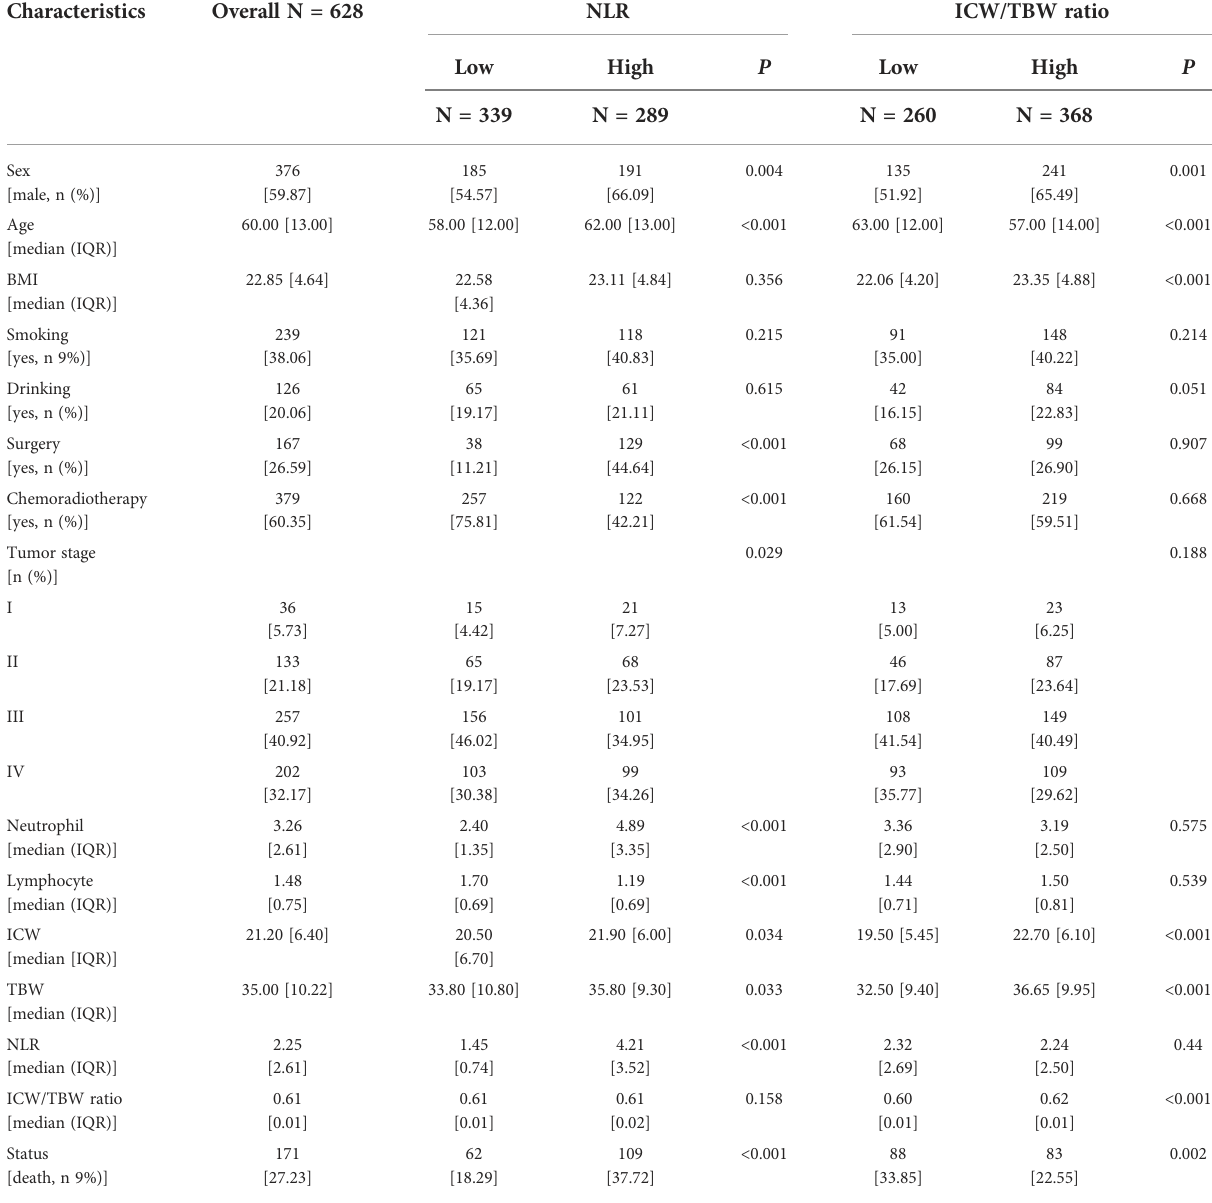
TABLE 1 Baseline characteristics of patients with colorectal cancer strati fi ed by NLR and ICW/TBW ratio.